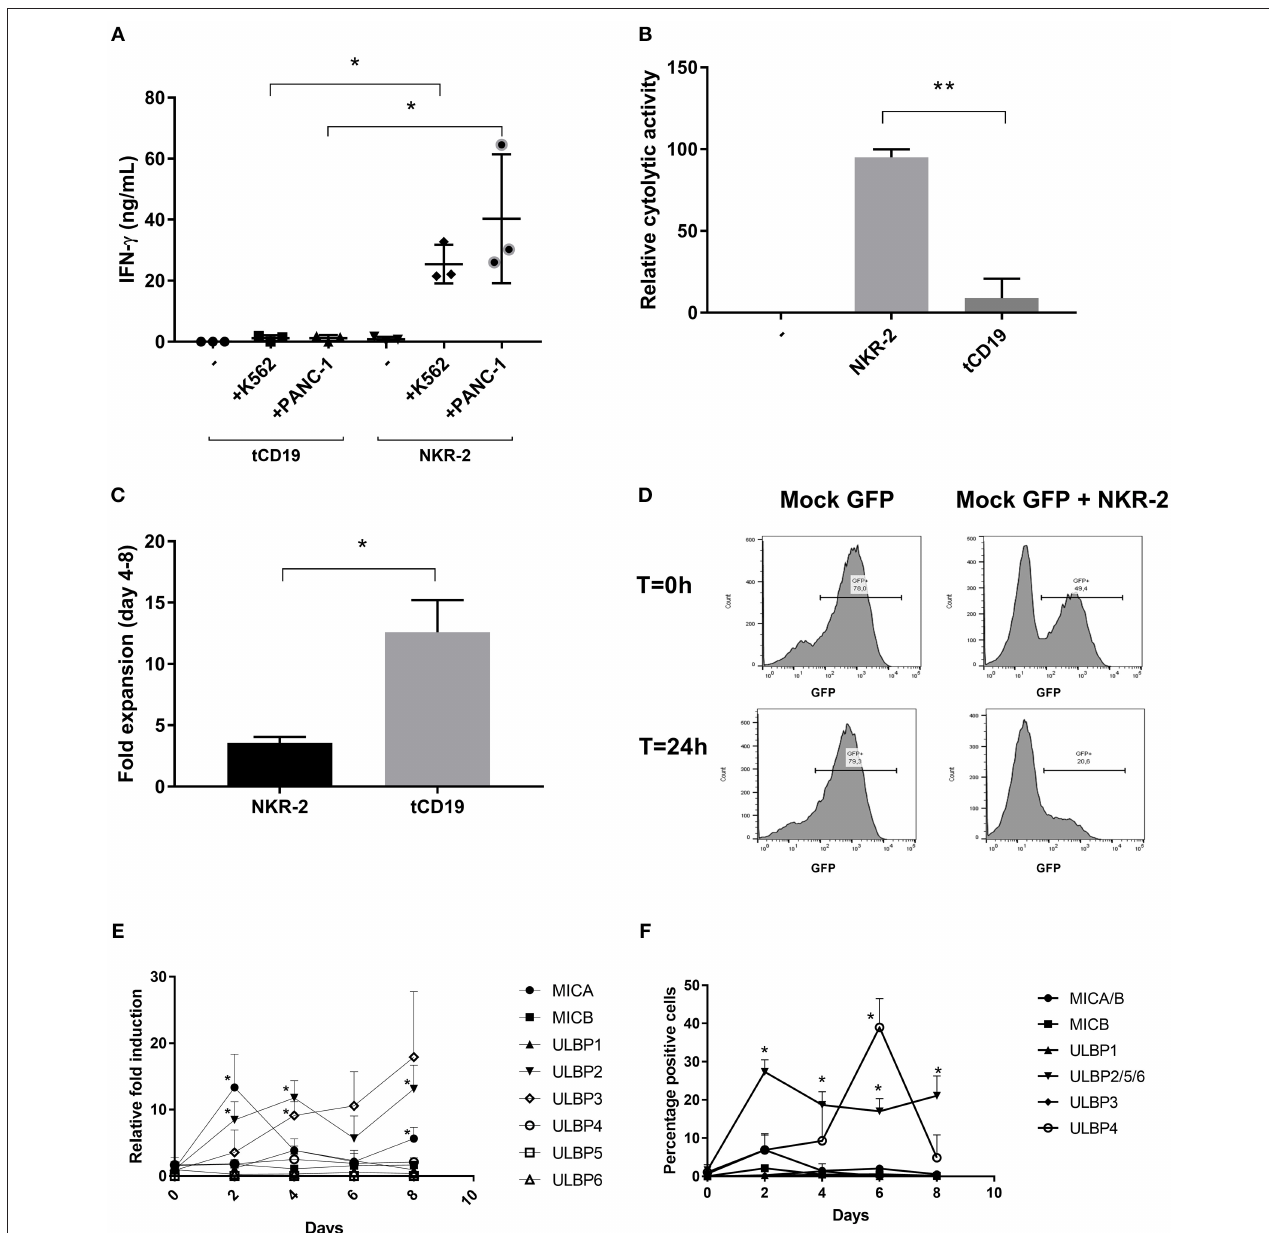
FIGURE 2 | NKR-2T cells recognize Chronic myeloid leukemia (K562) and Pancreatic Carcinoma (PANC-1) but display a fratricide effect due to NKG2DL expression. (A) T cells from healthy donors were transduced with tCD19 vector (tCD19T cells) or with the NKR-2T cells vector (NKG2D-CAR T cells) and co-cultured with indicated cell lines or alone (–). IFN- γ secretion (ng/ml) was quantified by ELISA after overnight coculture. Each data point represents the mean value of duplicate wells from independent experiments. Shown is ( N = 3). (B) NKR-2T cells exhibit cytolytic activity. PANC-1 were cocultured with thawed NKG2D-CAR T cells at an E:T ratio of 1:1. Alamar blue signal was determined after 20h. Percent lysis was determined by absorbance comparison with untreated cancer cells (PANC-1). Data shown are mean ± SD of N = 3 independent T cell donors.; –, PANC-1 cells alone; NKR-2T cells: Coculture of NKR-2T cells and PANC-1 cells; tCD19, Coculture of control tCD19T cells with PANC-1 cells. (C) Transduced T cells were cultured in complete X-vivo (100 IU/mL IL-2) for 4 days. T cells were analyzed 96h after seeding to analyze fold expansion relative to the initial cell seeding density. Data shown are mean ± SD of N = 3 independent T cell donors. (D) Representative co-culture experiment (out of three). GFP positive T cells were either cultured alone (Mock-GFP) or co-cultured with NKR-2T cells generated from the same donor (Mock GFP + NKR-2T cells). Flow cytometry analysis of GFP positivity was acquired at the beginning of the incubation ( T = 0h) or after 24h of incubation ( T = 24h). (E,F) PBMCs were activated with 40ng/mL anti-CD3 and 100 IU/mL IL-2 and kept in culture for a total of 8 days in accordance with the normal manufacturing protocol. Every 2 days cell samples were harvested and the expression of NKG2D ligands analyzed as either RNA (E) or proteins on the cell surface (F) . A two-tailed unpaired t -test was used to assess statistical significance. A p < 0.05 was considered significant (*) and p < 0.01 (**). For both qPCR and Flow cytometric comparison a paired two-tailed t -test was used.